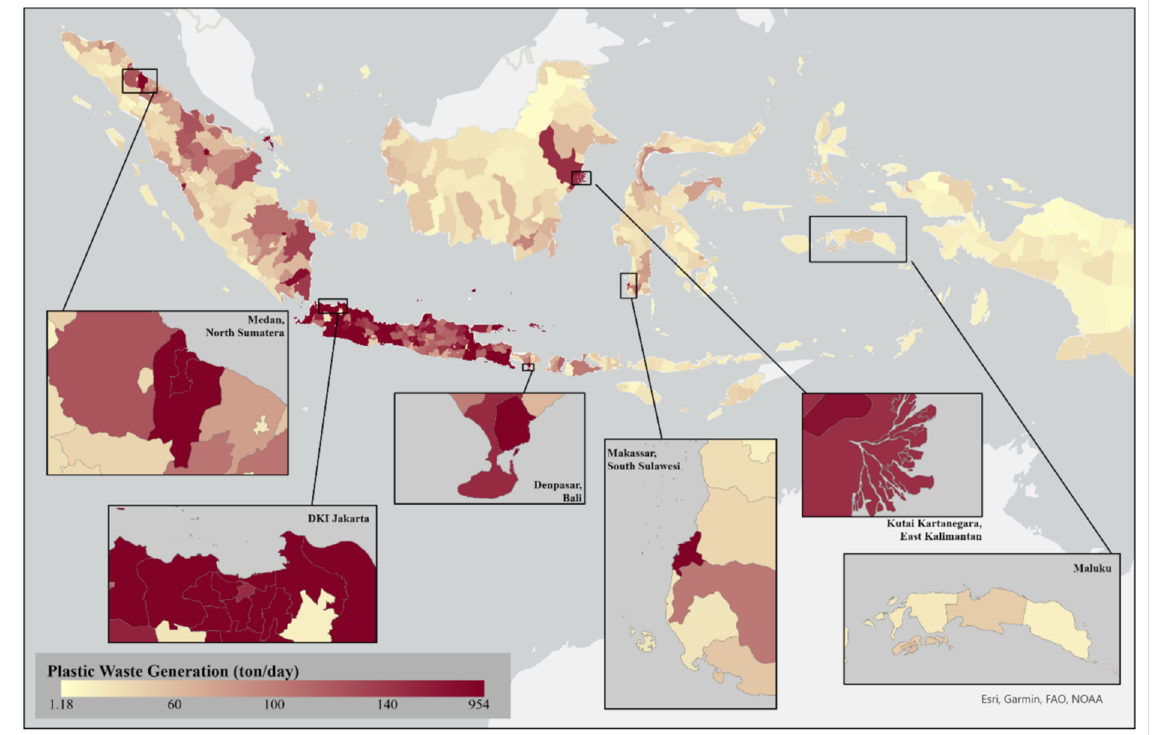
Figure 4. Plastic waste generation per regency area in Indonesia by tonne on a daily